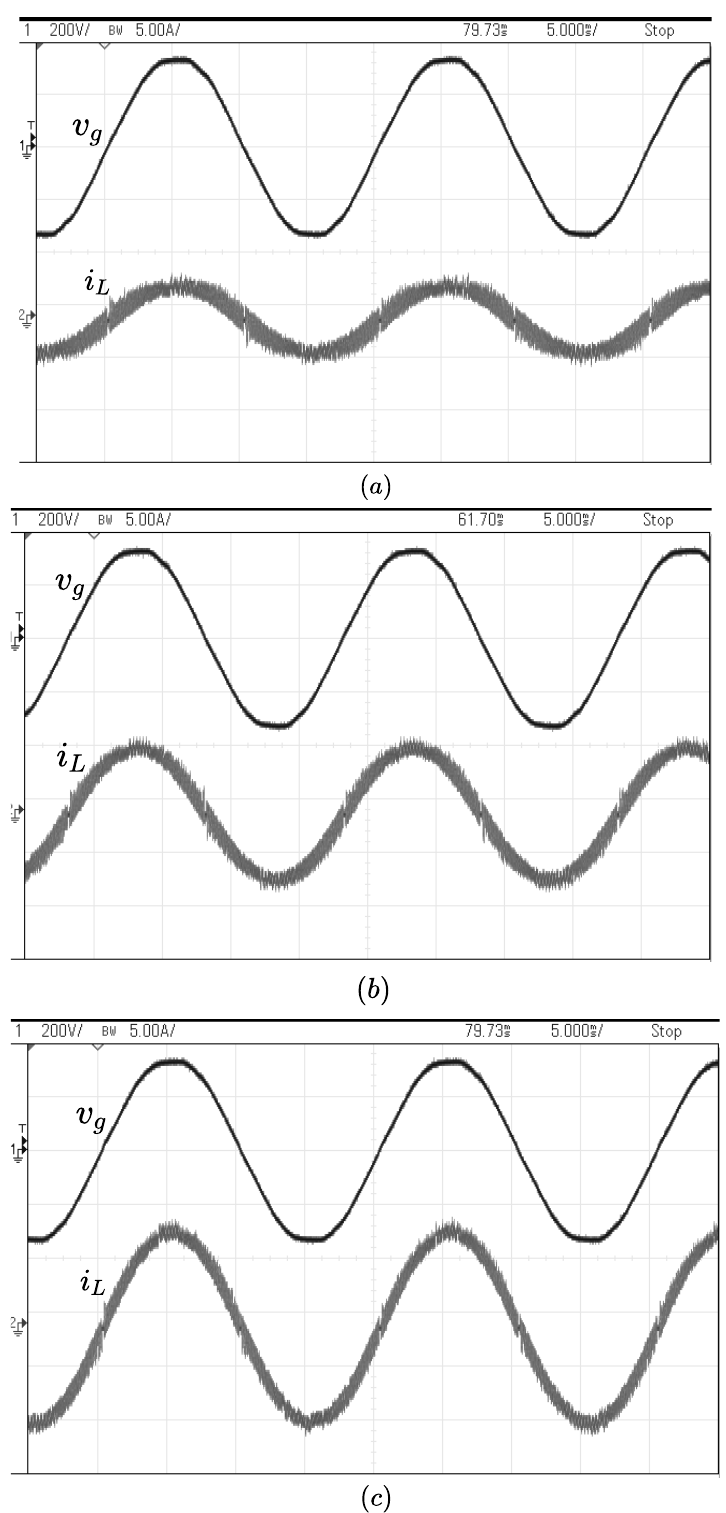
Figure 23. Synchronised operation of single phase GI-VSI delivering ( a ) 0.5 kW ( b ) 1 kW ( c ) 1.5